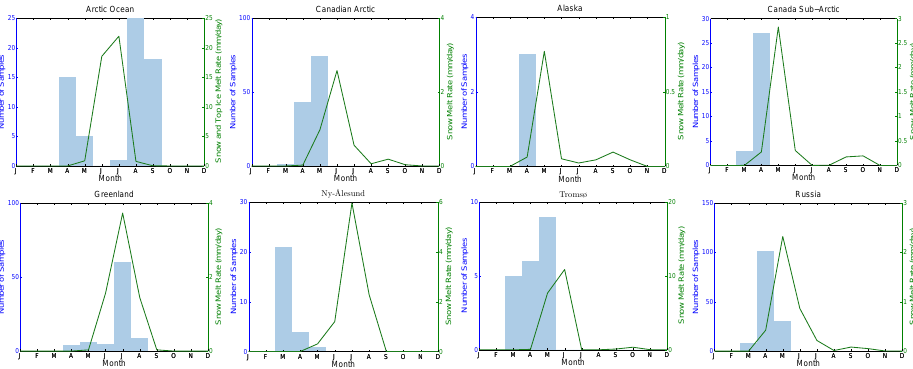
Fig. 12. Histogram of the months when the samples are collected in each region (plotted against left axis) and seasonal cycle of snow and ice melt rates (plotted against right axis). The melt rates are averaged only over grid cells containing observations within each region.